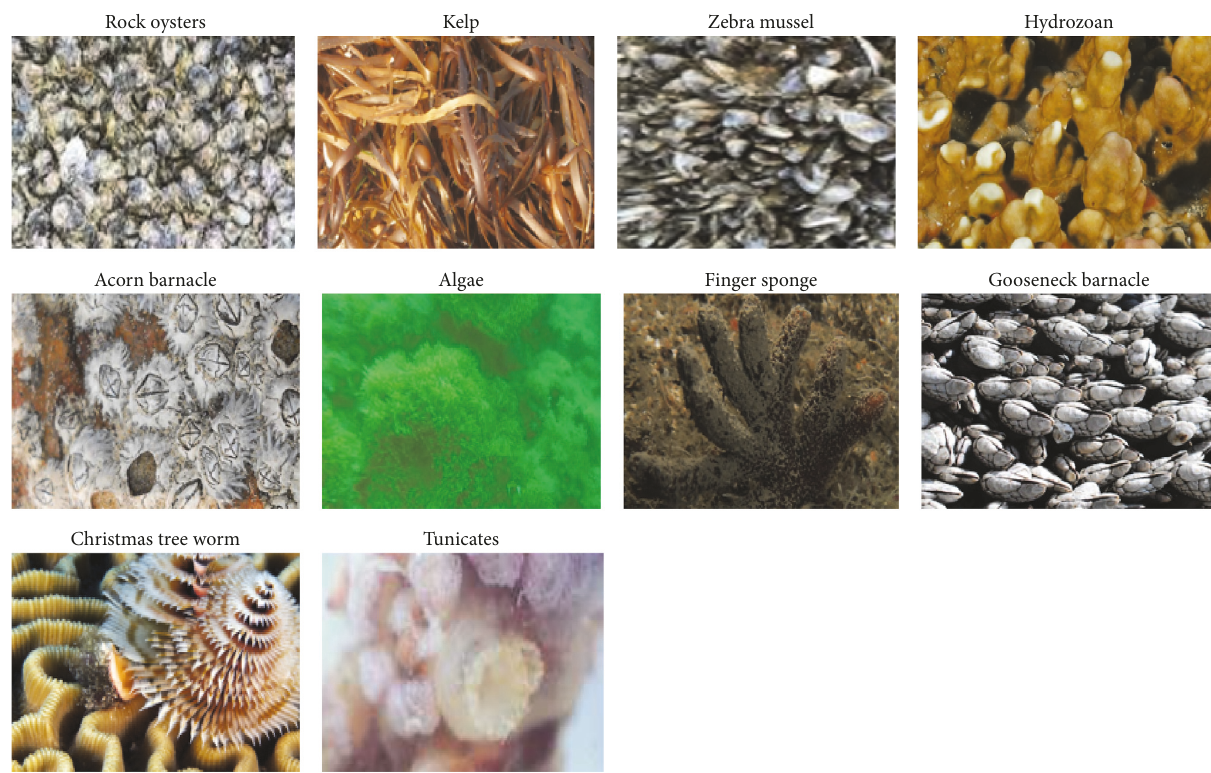
Figure 3: Different classes of fouling images used for training.